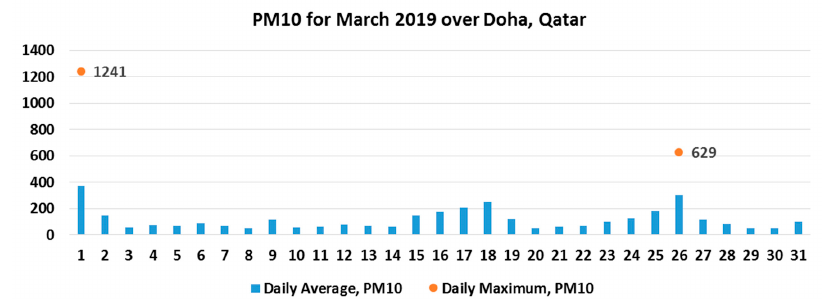
Figure 11. The PM 10 daily average concentration (blue bars) over Doha for the month of March 2019. The dates 1 March and 26 March, 2019 are used as case studies of extremely high PM 10 concentrations to validate the model.